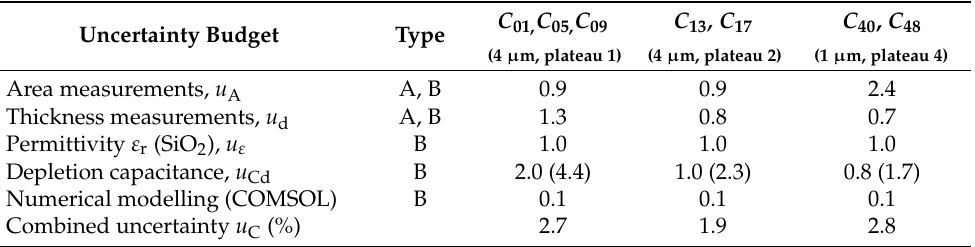
Table 3. Uncertainty budget corresponding to the capacitance calculation for the capacitors C 01 , C 05 , C 09 , C 13 , C 17 , C 48 of MC2 samples. Uncertainties are given in relative value (%). Values inside bracket correspond to uncertainty when the error is not corrected.